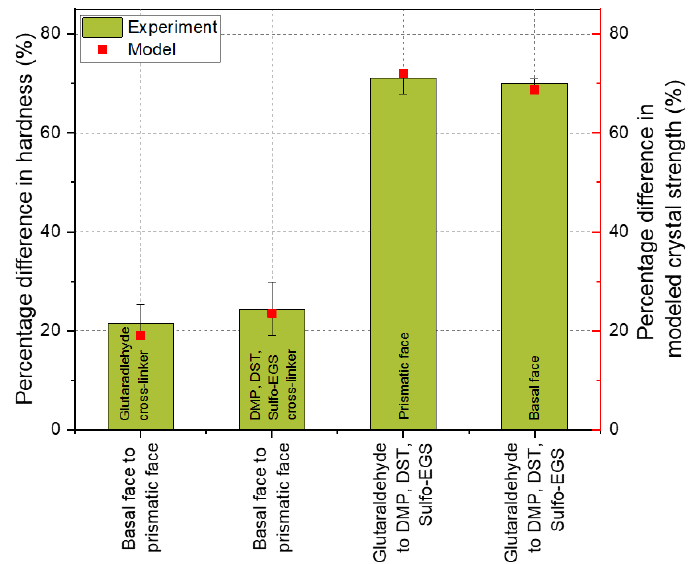
Figure 5. Comparison of the experimental and the modeled results of differently cross-linked wild- type HheG crystals. The bars represent the percentage differences between the mean hardness of the respective crystal faces considered, as described in the diagram. The square dots represent the modeling results, which are also represented as the percentage difference between the corresponding crystal faces. The error bars show the percentage differences of the upper and lower quartiles of the distribution of mechanical properties.